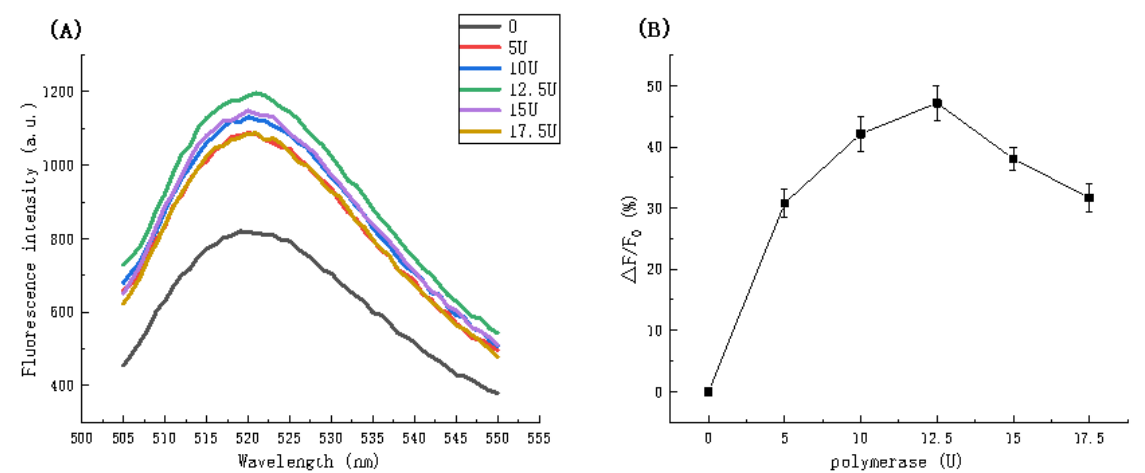
Figure 5. ( A ) Fluorescence spectra in the presence of different polymerase dosages. ( B ) The relationship between fluorescence intensity ratio ( △ F / F 0 ) and polymerase dosage.